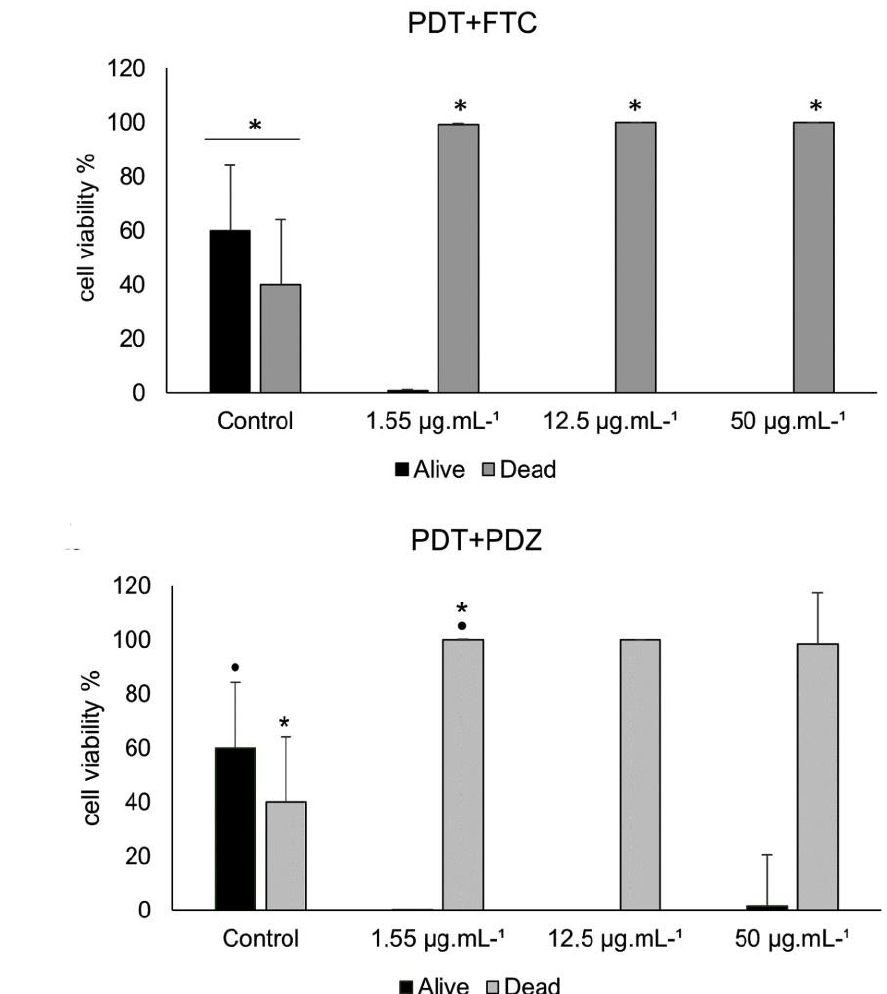
Figure 4. ( A )—Number of cells present in the supernatant 18 h after PDT application at a fluence of 5 J/cm 2 in gliosarcoma cells with FTC and PDZ and control groups. Symbols for p < 0.01: * and α . ( B )—Viability of the cells in the supernatant 18 h after PDT with FTC, and control group irradiated at 5 J/cm 2 . ( C )—Viability of the cells in the supernatant 18 h after PDT with PDZ, and control group irradiated at 5 J/cm 2 . Symbols for p < 0.01: * and •.